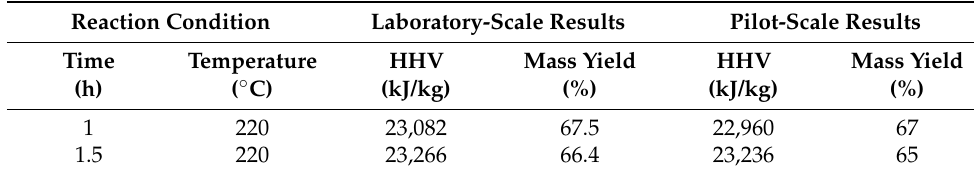
Table 6. Comparison of calorific value and mass yield after HTC of waste wood at the laboratory and pilot scales.